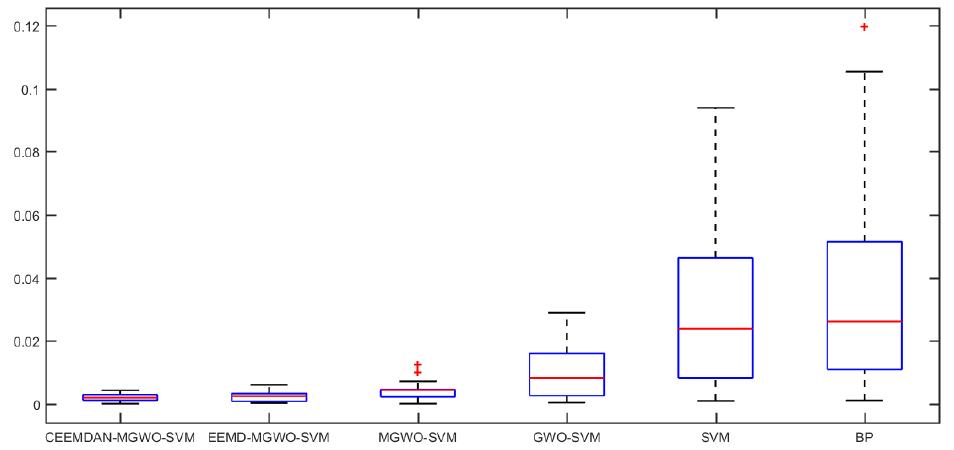
Figure 11. The boxplot of relative errors for different models.